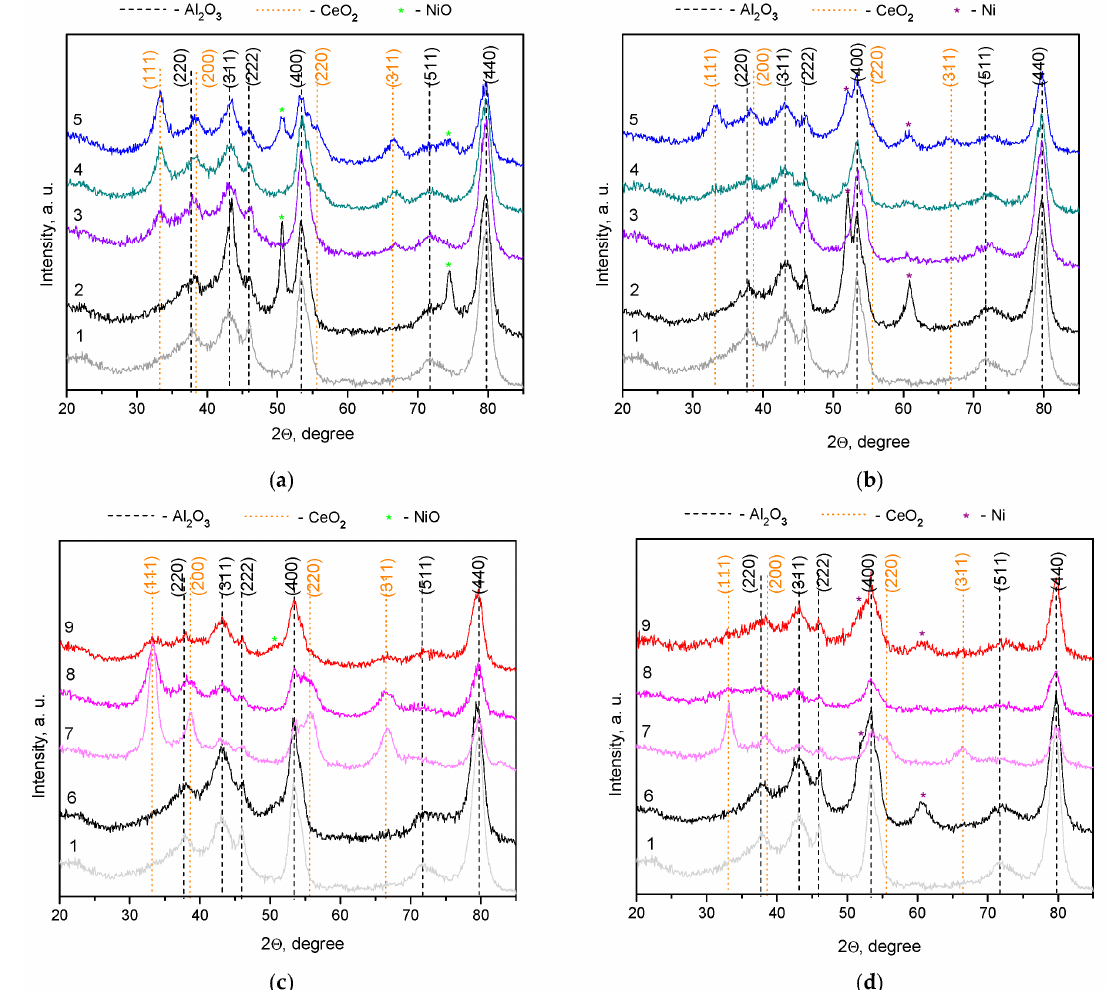
Figure 4. XRD patterns of Al 2 O 3 support (1), 10Ni/Al 2 O 3 -CI (2), 5Ce 0.2 Ni 0.8 O 1.2 /Al 2 O 3 -CI